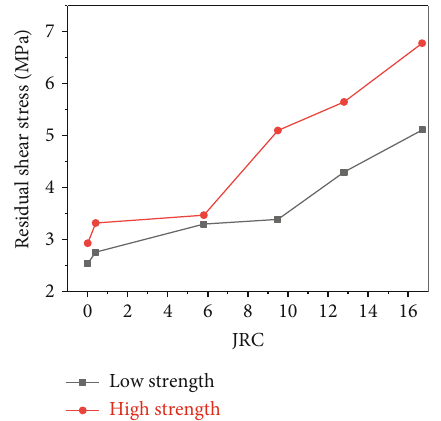
Figure 4: Residual shear strength of low-strength and high- strength rock joints with di ff erent